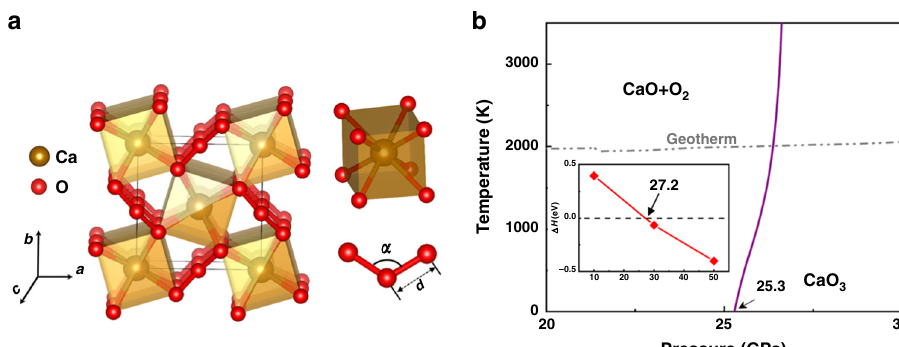
Fig. 1 Crystal structure and phase stability of CaO 3 . a Crystal structure of the newly identi fi ed tetragonal phase of CaO 3 . b Thermodynamic phase diagram of CaO 3 determined using fi rst-principles density functional theory, including the proton zero-point motion at the harmonic level, highlighting the phase boundary for decomposition into CaO and O 2 in reference to the geotherm line. The purple line is the phase boundary for CaO 3 decomposition into CaO and O 2 . The gray dotted line presents the geotherm of the Earth from ref. 48 . The inset shows calculated formation enthalpy of CaO 3 with respect to decomposition into CaO and O 2 as a function of pressure at zero